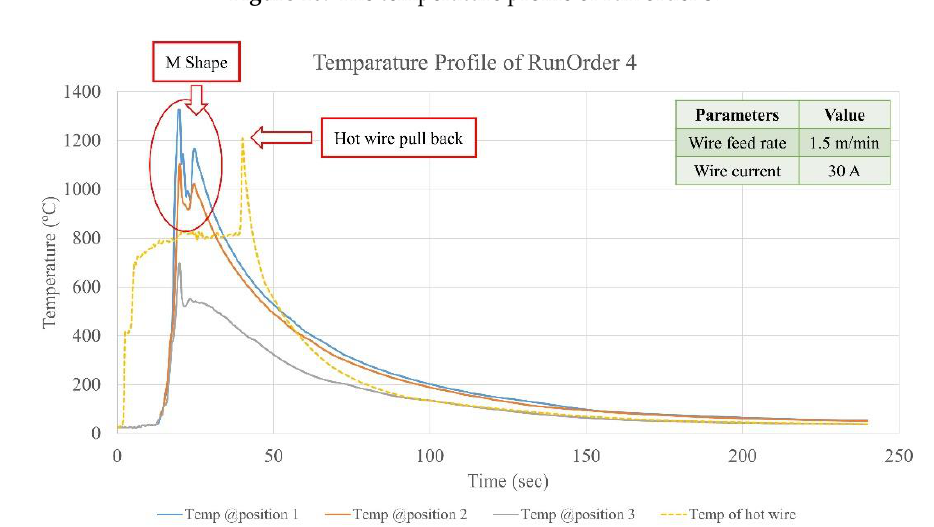
Figure 10. The temperature profile of run order 3.